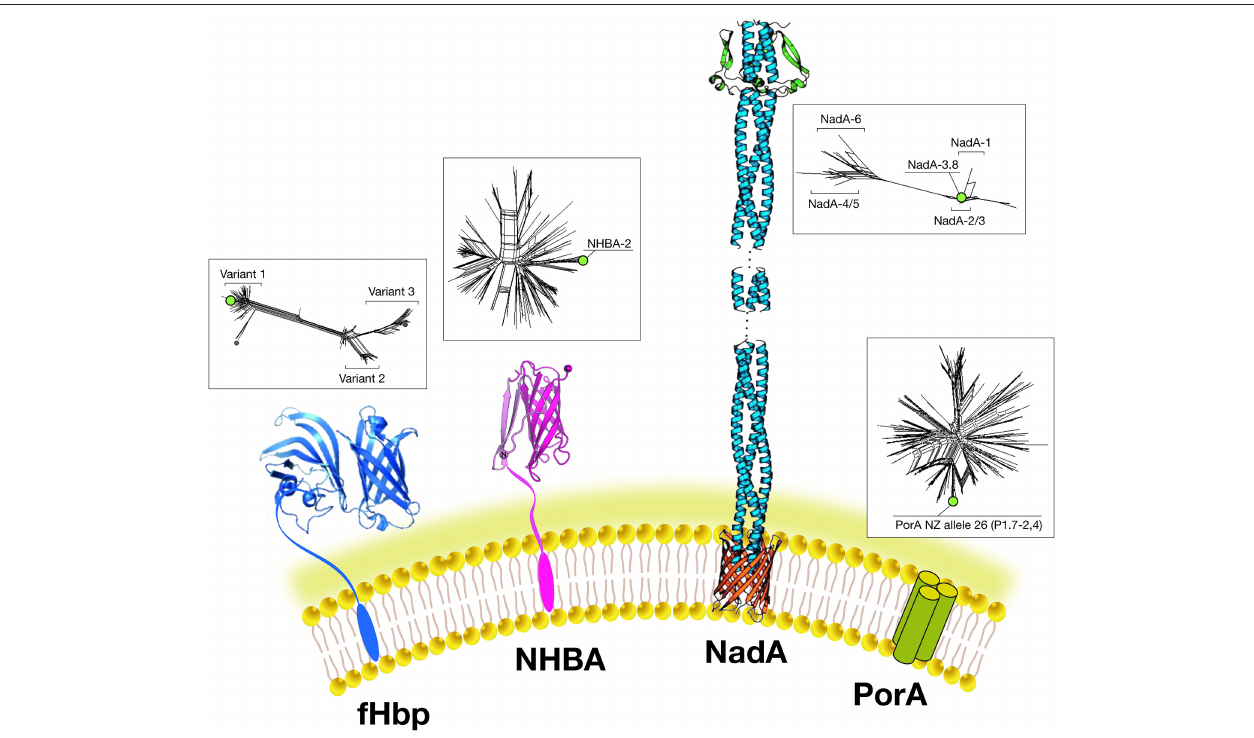
FIGURE 3 | Main components of the 4CMenB vaccine: Schematic representations of the three-dimensional structures of vaccine antigens based on full length x-ray structure of fHbp, depicted in dark blue ( 37); x-ray structure of the C-terminal domain of NHBA depicted in purple (38, 39). X-ray structures of the trimeric head and stalk domains of NadA molecule shown in light blue; the anchor region (in red) is modeled according to predictions from other outer membrane proteins ( 40, 41); the N-terminus of the NHBA antigen is predicted as unfolded and has proved resistant to crystallization so far. Schematic model of the trimeric PorA molecule (the immunodominant antigen of the OMV) is depicted in green. Three-dimensional structure of PorA is not available yet. Within boxes are shown phylogenetic trees to indicate the sequence variability of the fHbp, NHBA, NadA, and PorA antigens included in 4CMenB. Green dots indicate the antigen variants present in